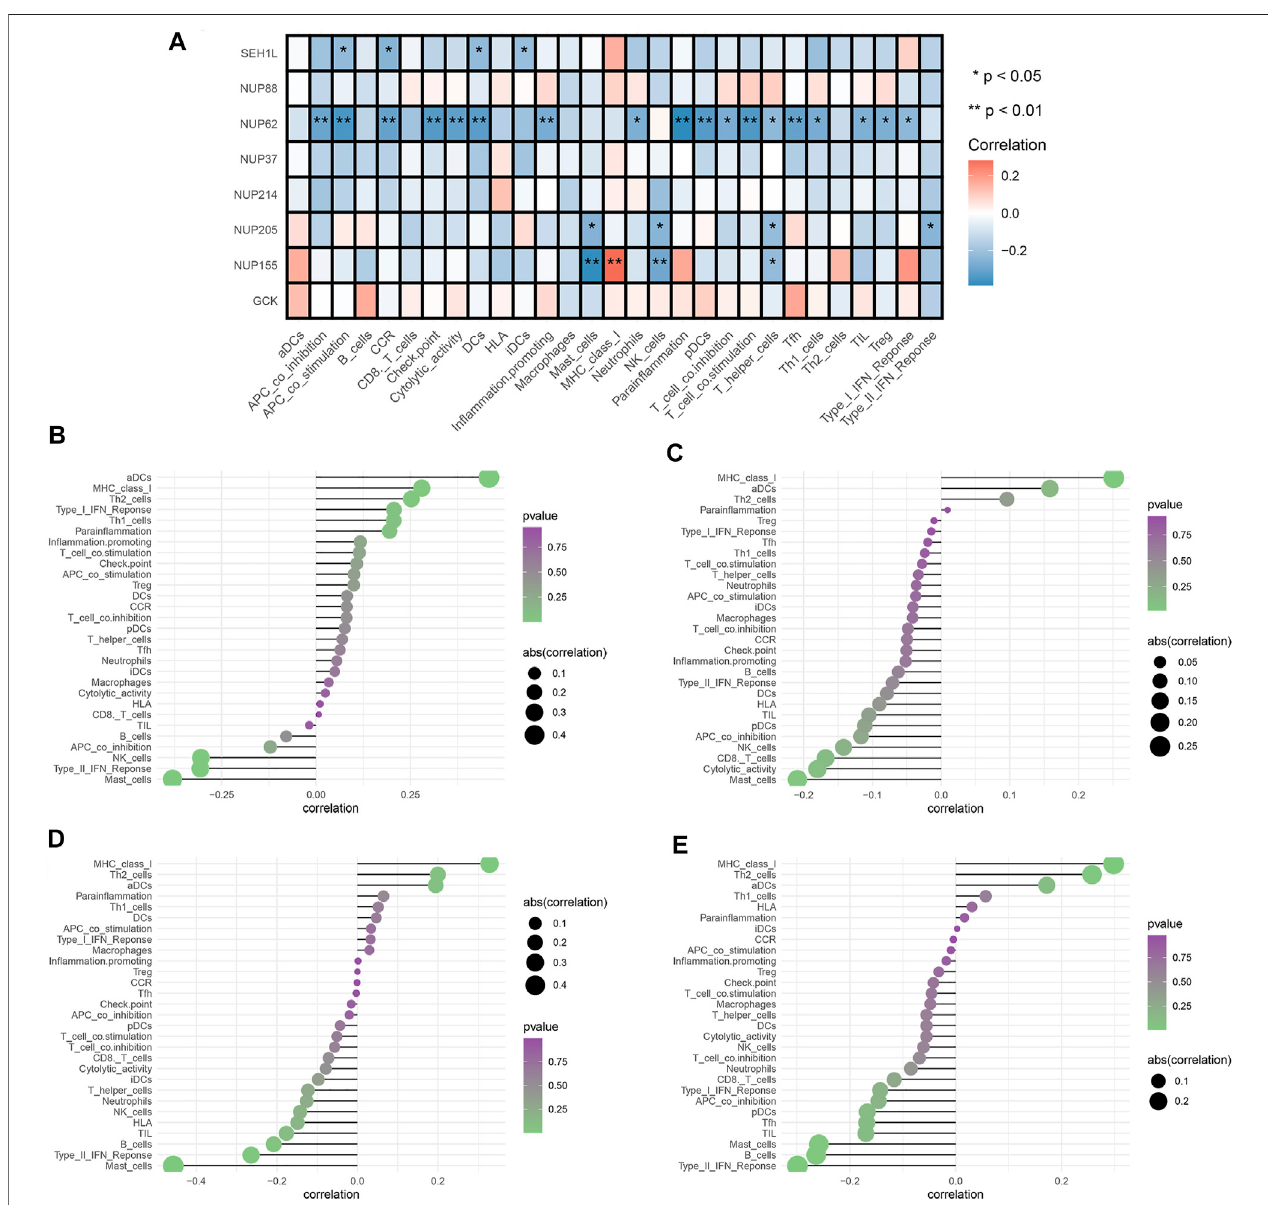
FIGURE 5 | Analysis of glycolytic gene effects on immune signatures. (A) Heatmap demonstrating the correlation between 8 genes and the ssGSEA scores of 29 immunesignatures. (B) NUP62and immune signatures. (C) NUP155and immunesignatures. (D) NUP205and immune signatures. (E) SEH1Land immunesignatures. Spearman ’ s correlation analysis was used to evaluate the relations with p <